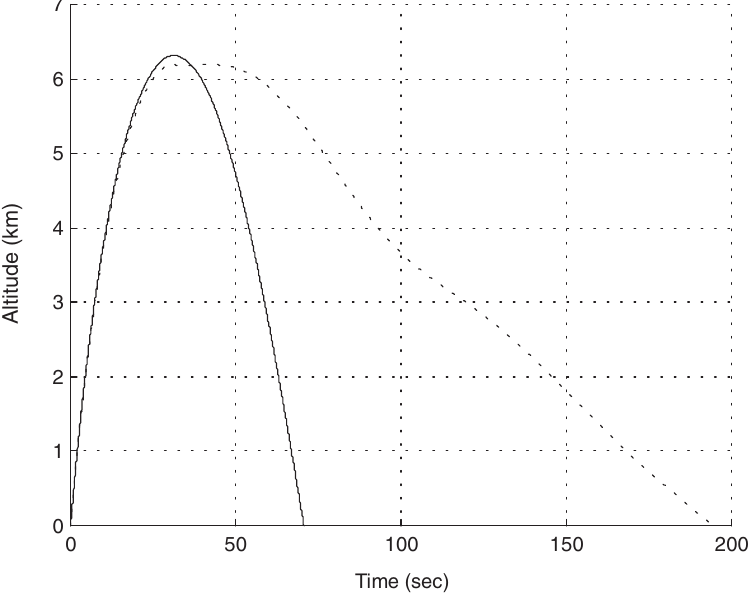
Fig. 7. Altitude vs. time (Solid = Nominal, Dotted = Extended).